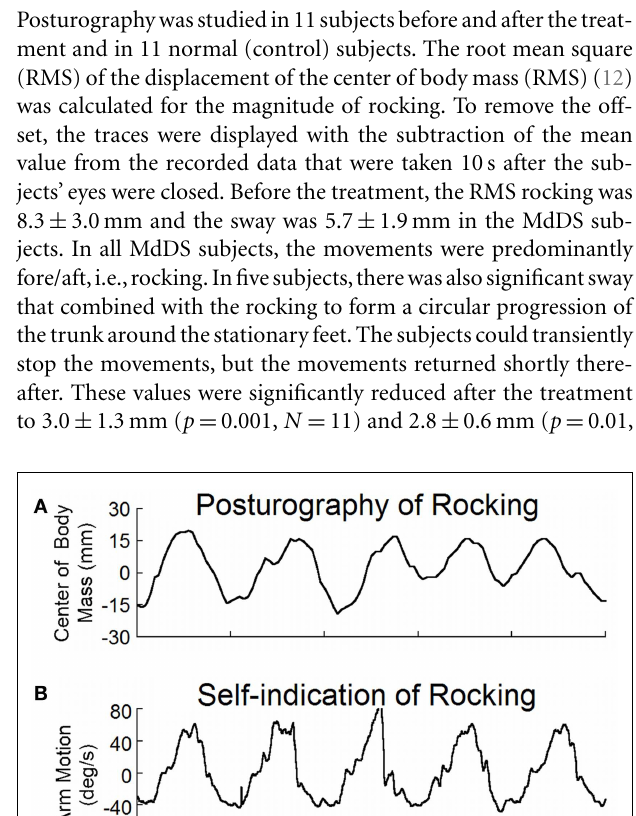
FIGURE 3 |Vertical (pitch) eye position (C) and velocity (B) induced by head roll (A) at about 0.2Hz in darkness . (B) The dark traces show the slow phase eye velocity and the gray traces the quick phases, blinks and fluttering of the eyelid.The peak velocity of the vertical eye oscillations was about ± 4°/s estimated by a sine function approximation.The vertical dash line shows the relationship between the head position in roll and slow phase vertical eye velocity and position.The slow phase eye velocity was upward when the head was rolled to the right and down when the head was rolled to the